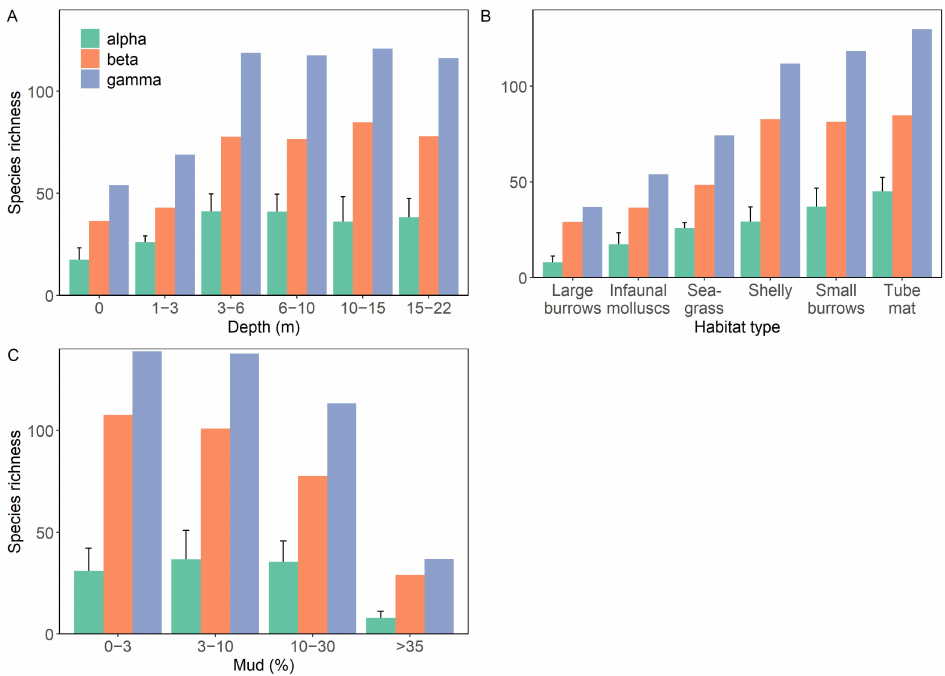
Figure 3. Within-in category α -, β - and γ - diversity as a function of ( A ) water column depth (m), ( B ) habitat type or ( C ) sediment mud content (%). α -diversity is displayed as mean ± SD. These patterns of diversity were reflected when comparing three different diver- sity indices (Shannon-Weiner diversity, Simpson’s diversity and Pielou’s evenness